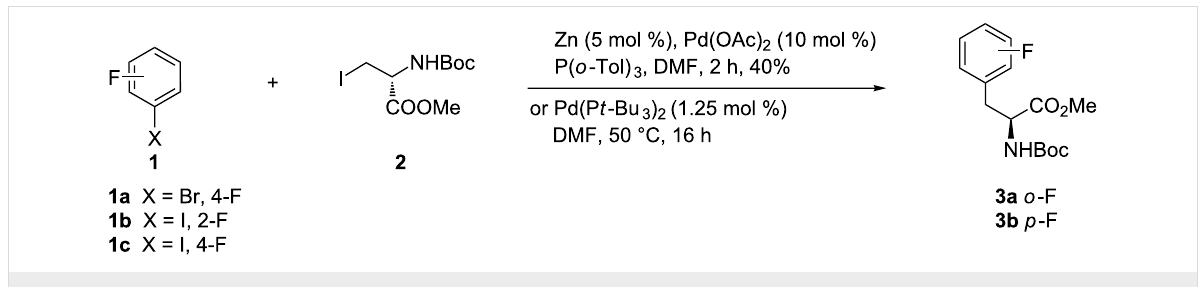
Scheme 1: Synthesis of fluorinated phenylalanines via Jackson’s method.